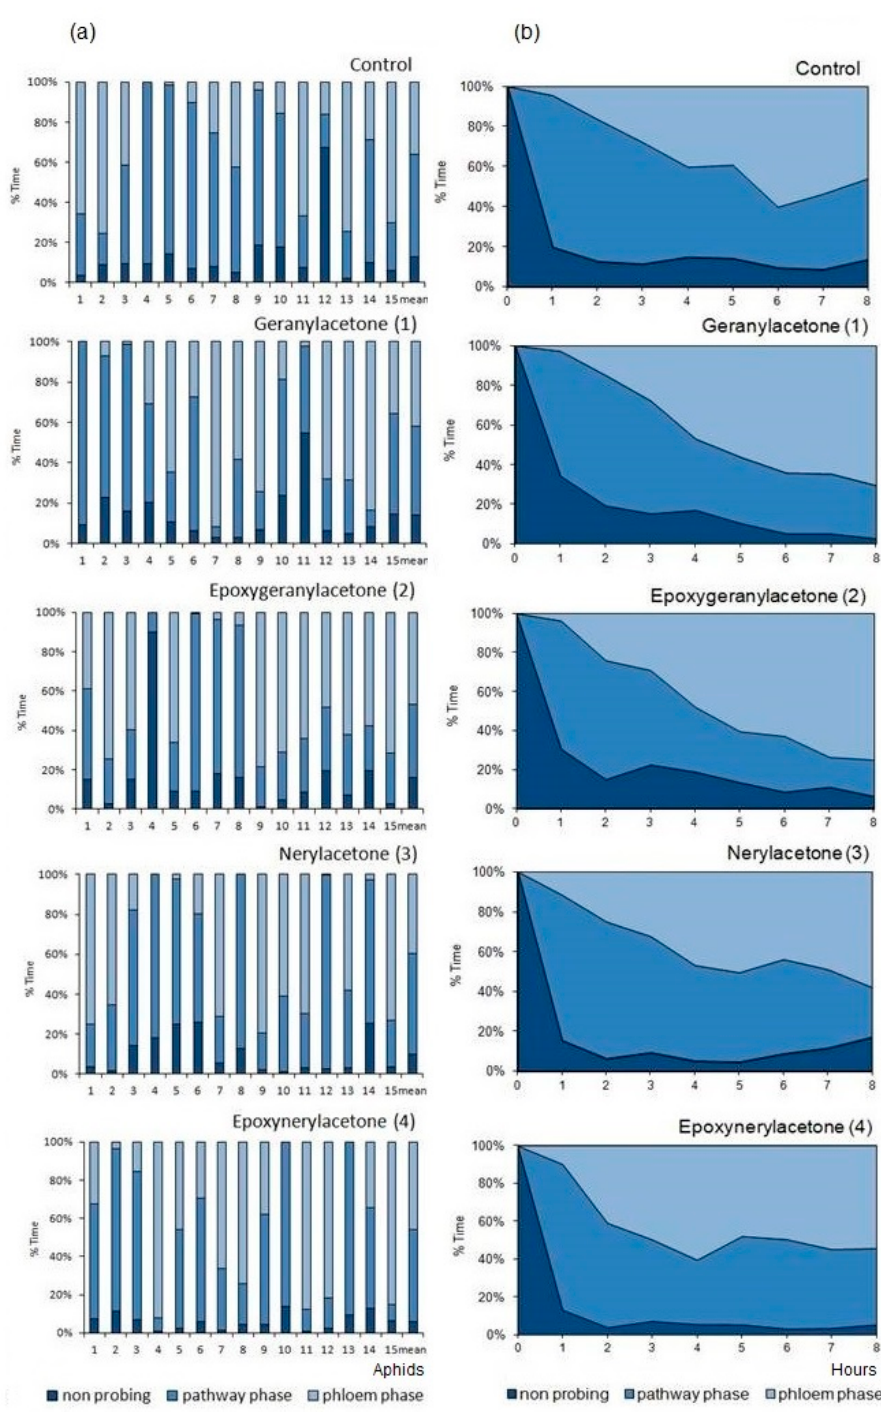
Figure 3. A general outline of the probing behavior of Myzus persiace on Brassica rapa subsp. pekinensis treated with sesquiterpenoids geranylacetone ( 1 ), epoxygeranylacetone ( 2 ), nerylacetone ( 3 ), and epoxynerylacetone ( 4 ) . ( a ) Individual variation in probing behavior of M. persicae on control and sesquiterpenoid-treated plants; numbers denote individual aphids. ( b ) Sequential changes in M. persicae probing behavior on control and sesquiterpenoid-treated plants; non-probing (aphid stylets outside the plant), pathway phase (probing in non-phloem tissues; waveforms A, B, C, F, and G); phloem phase (waveforms E1 and E2).